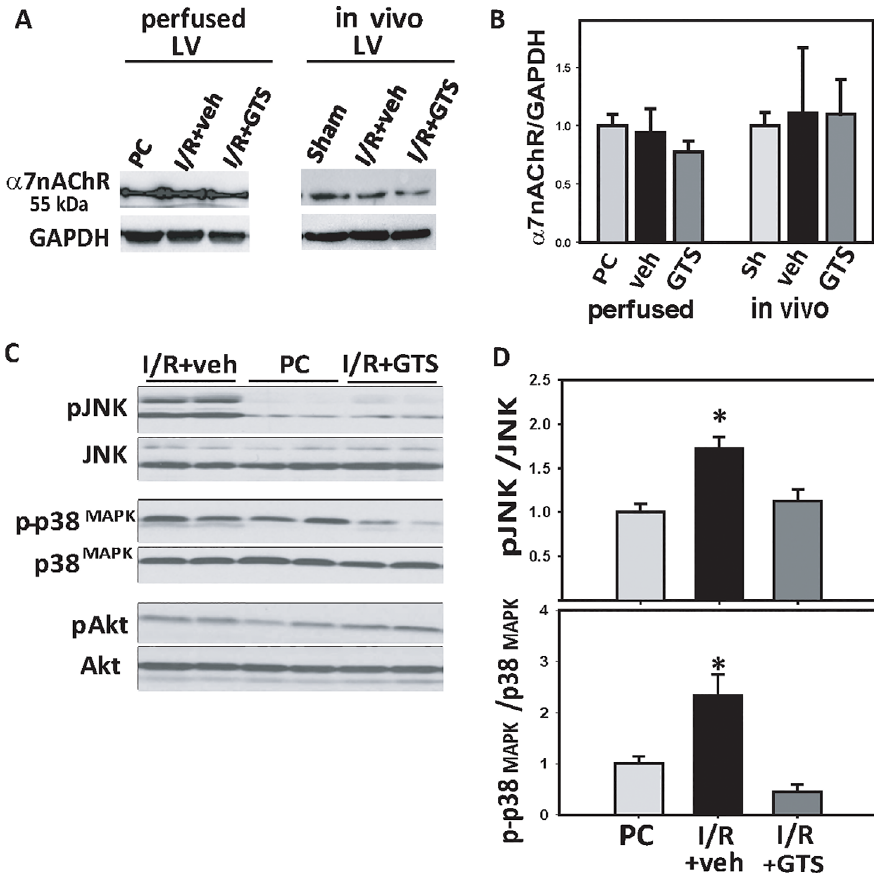
Figure 4. Intracellular signaling pathway activation in isolated perfused rat hearts ex- posed to I/R. (A) Representative Western blots (WB) showing α 7nAChR protein content in rat LV of in vivo and ex vivo models of I/R injury treated with GTS21 or vehicle; PC, perfu- sion control; no statistical differences among groups (n = 4–5/group). (B) Quantitation of immunoblots in (A) showing α 7nAChR normalized to GAPDH. (C) Representative immuno- blots for JNK, p38 MAPK , AKT and their phosphorylated isoforms in I/R perfused LVs treated with vehicle or GTS21. (D) Quantitation of the WB shown as bar graphs for phospho-JNK to total JNK and p-p38 MAPK to total p38 MAPK ratios normalized to PC. Values are mean ± SE; * p < 0.01 versus all groups. Statistical significance determined by one-way